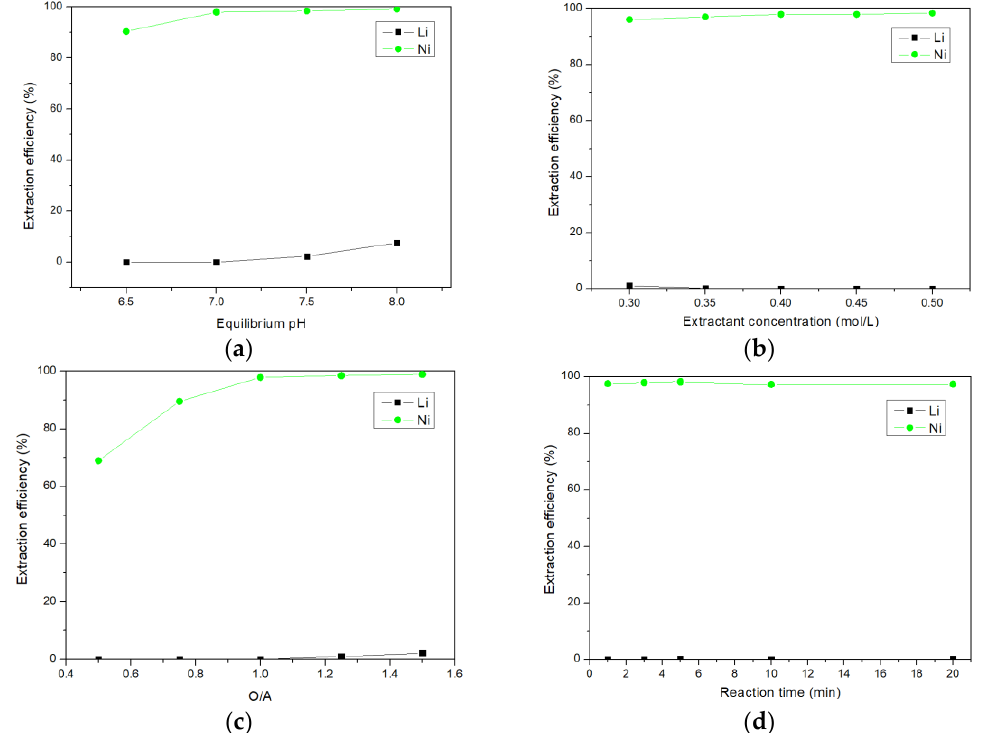
Figure 6. Effects of ( a ) pH ([Cyanex272] = 0.4 M, O/A = 1, t = 15 min), ( b ) extractant concentration (pH = 7.0, O/A = 1, t = 15 min), ( c ) oil – water ratio (pH = 7.0, [Cyanex272] = 0.4 M, t = 15 min), and ( d ) reaction time (pH = 7.0, [Cyanex272] = 0.4 M, O/A = 1) on nickel extraction. Table 6. The relationship between the equilibrium pH and separation coefficient. Extractant Concentration